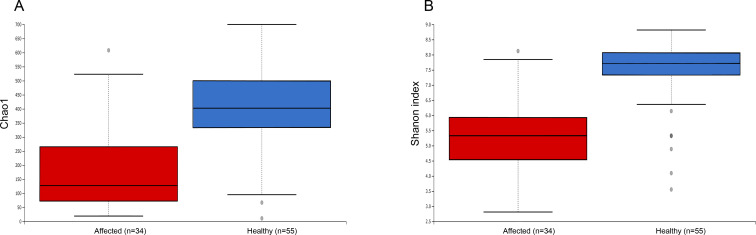
Alpha diversity analysis between healthy and affected dogs.Differences in alpha diversity metrics between healthy and affected dogs: (A) Chao1 index; (B) Shannon index.